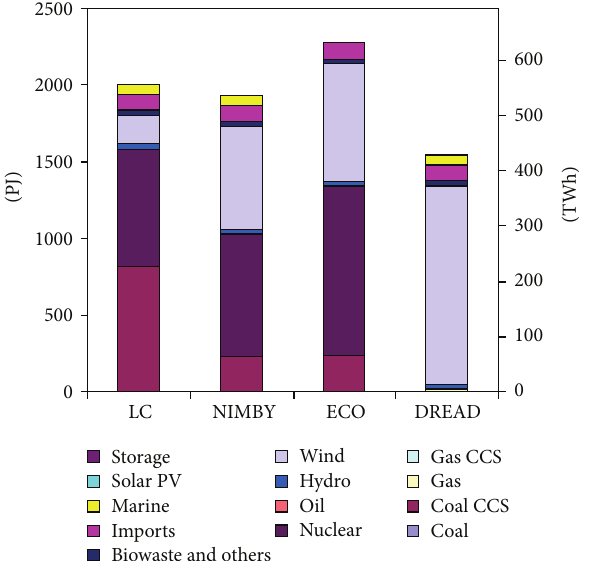
Figure 3: Electricity installed capacity in 2050. Scenarios are the low carbon (LC) baseline and the three socio-environmental forms (NIMBY, ECO, and